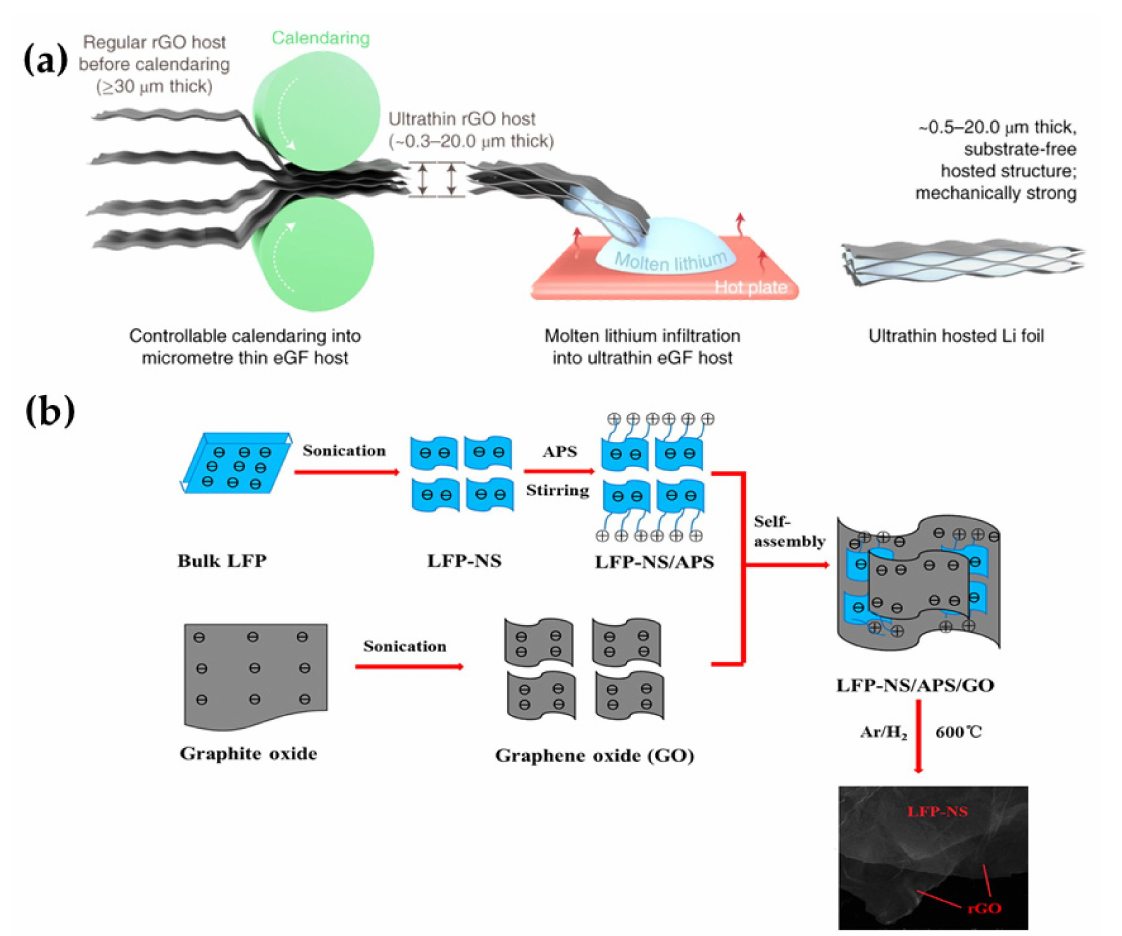
Figure 7. ( a ) Calendaring process for porous, thin Li foils (adapted with permission from Ref. [65]. 2021 Nature Energy) ( b ) Schematic of self-assembled LFP nanosheets with rGO (adapted with permission from Ref. [66]. 2017